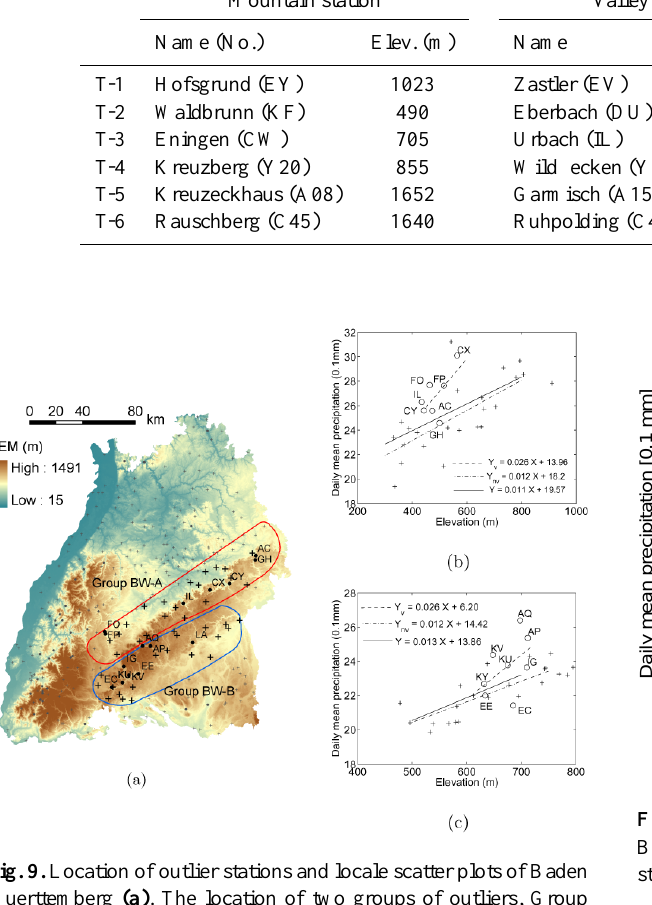
Fig. 11. Location of outliers and local scatter plot with trendlines (circles indicate valley stations, and crosses indicatenon-valleystations,thetrendlinesarealsoshowninthefigure.).